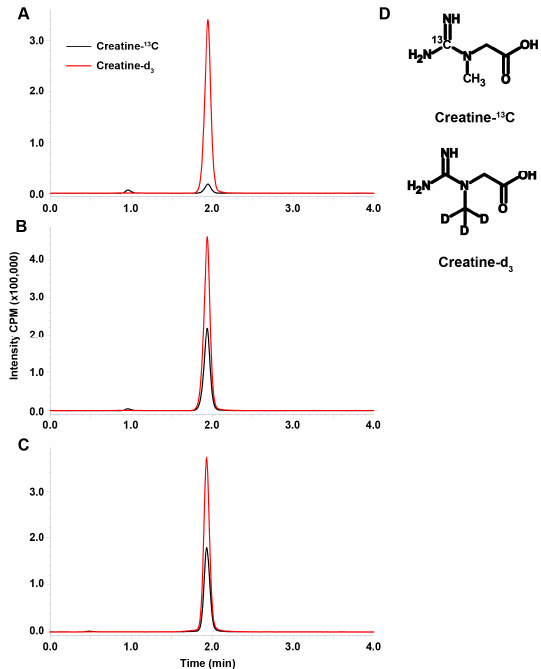
Figure 1. The representative chromatograms of creatine- 13 C (black) and creatine-d 3 (red) in blank plasma ( A ), a 10 μ g/mL standard sample of creatine- 13 C in plasma ( B ), and an unknown rat plasma